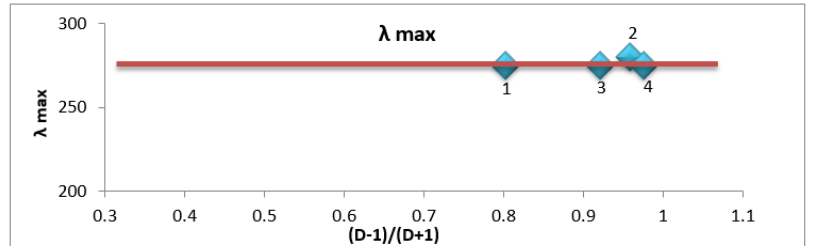
Fig. 5. The relation between the dipole moment constants and the maximum wavelengths of (A 2 ) using different solvents (1- Chloroform , 2- DMSO, 3- Ethanol, 4- Methanol.)